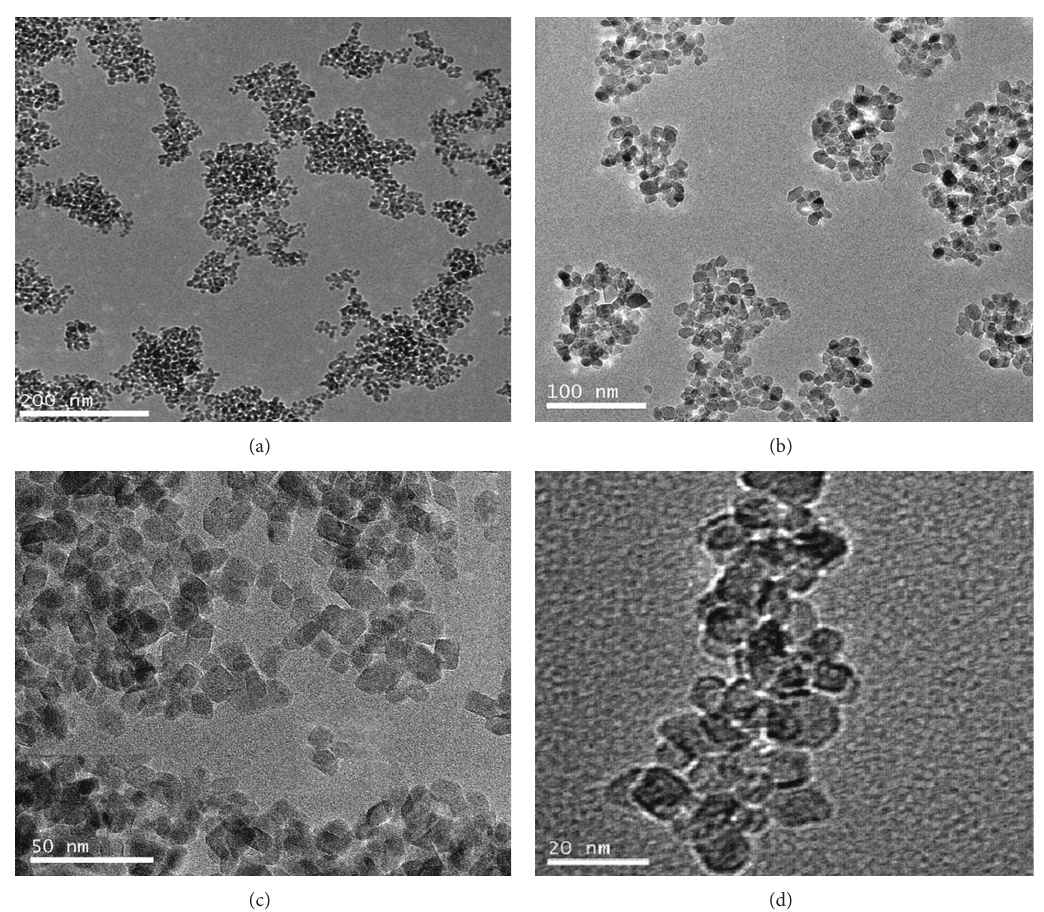
Figure 2: TEM images of the as-synthesized TiO 2 in different magnifications.